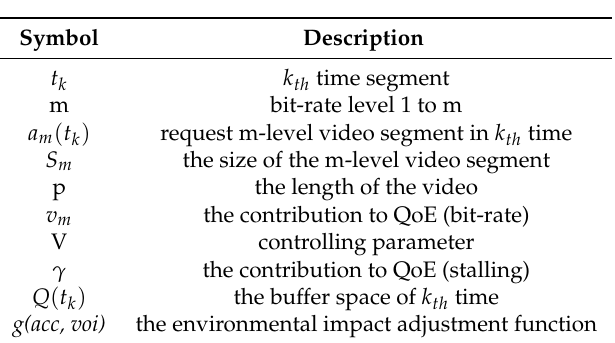
Table 2. Explanation of